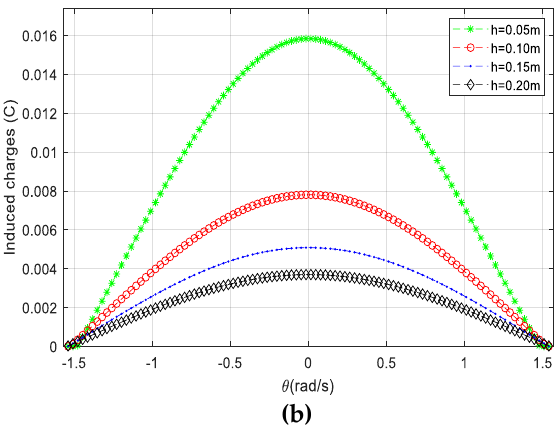
Figure 4. Induced charge density along θ : ( a ) Illustration of the point charge position, and ( b ) induced charge density.